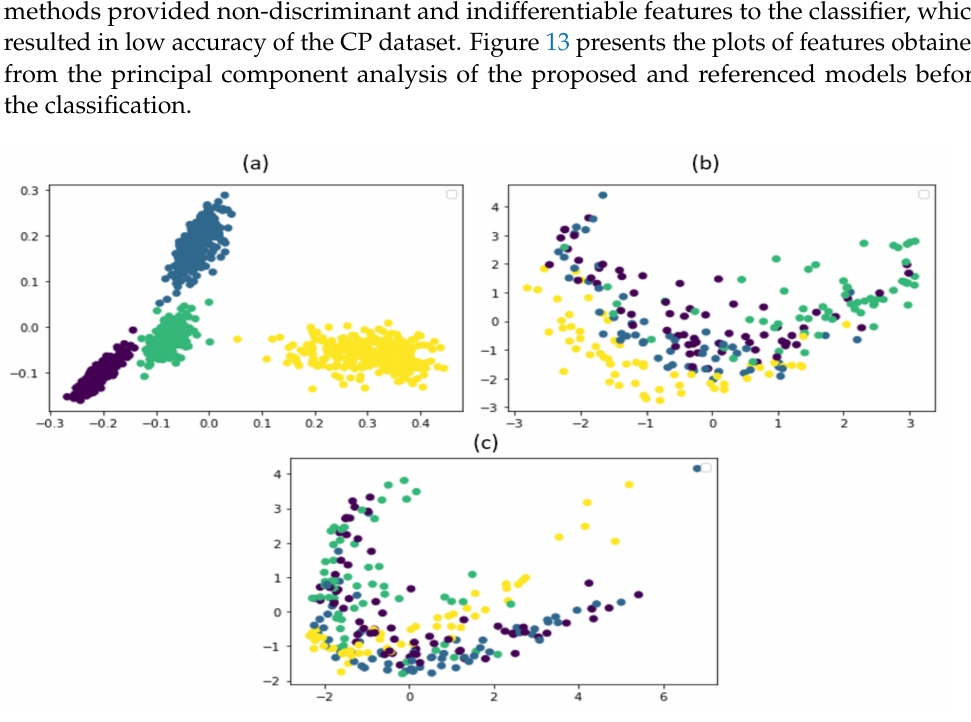
Figure 13. PCA feature plots of the ( a ) proposed method, ( b ) the SAE-based fault detection scheme, and ( c ) the DAE feature learning